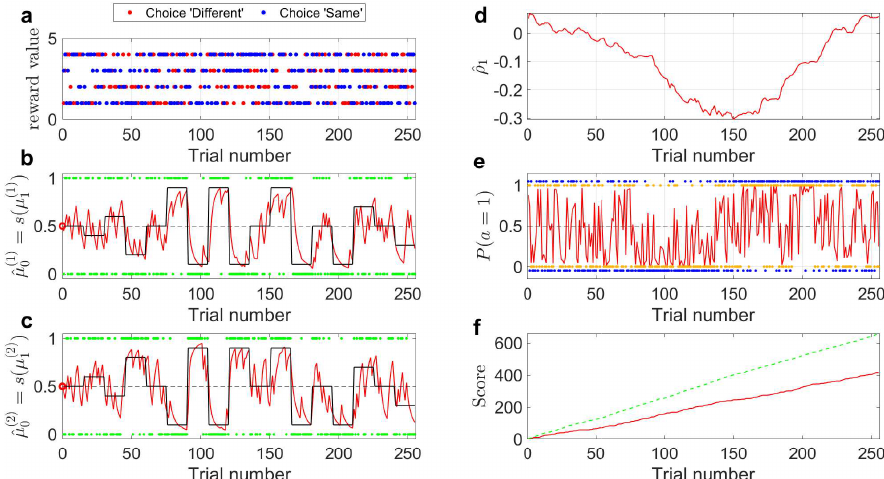
Figure 6. Temporal dynamics of the posterior states in a gambling task. ( a ) Rewards for two choices ( 1,4 ) . Blue “Different’ and “Same” were randomly generated by a discrete uniform distribution U dots represent the reward value for option “Same” on each trial, and red dots for option “Different”. ( b ) The green dots are the sensory inputs of u ( 1 ) (i.e., states of arm A). The red line represents the ( 1 ) ( t ) = s ( µ ( 1 ) ( t ) , ζ ( 1 ) ) . ( c ) The green dots are the sensory inputs of u ( 2 ) estimated probability ˆ µ k k 1 0 1 1 − ( 2 ) ( t ) = s ( µ ( 2 ) ( t ) , ζ ( 2 ) ) . (i.e., states of arm B). The red line represents the estimated probability ˆ µ k k 1 0 1 1 − ( d ) Prediction correlation ˆ ρ 1 ( t ) is extracted from the inverse prediction precision ˆ Π 1 ( t ) generated by the second (log-volatility) level. ( e ) Blue dots denote the optimal choice a ideal on each trial. The red line is the trajectory of the expectation probability that the states of two arms of the bandit are the same (i.e., P ( a = 1 ) ). The orange dots are the response action a generated by the agent on each trial. ( f ) The green dashed line is the cumulative reward of the ideal observer taking the ideal actions a ideal . The red line shows the cumulative reward obtained by the Bayesian